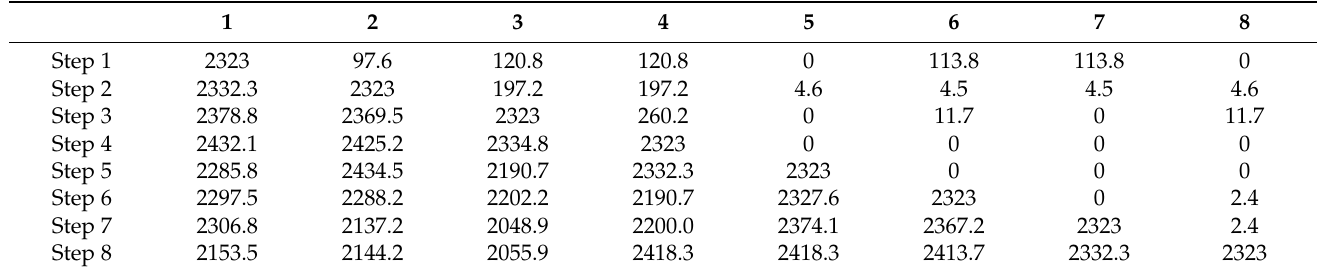
Table 3. Variation of bolt preload during assembly (unit: N).